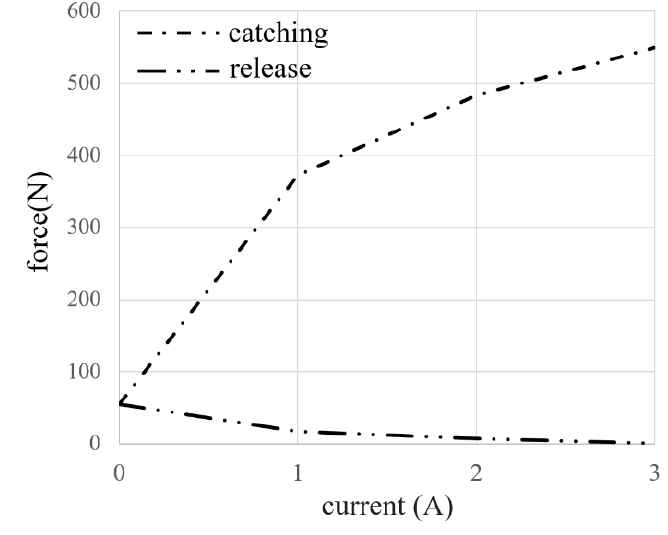
Figure 11. Experimental test results of maximum attraction force during the releasing pulse and catching pulse.